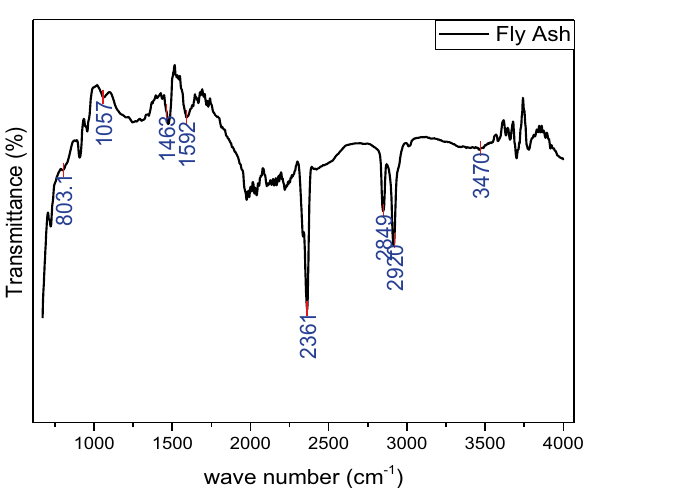
Figure 4. FTIR spectrum of fly